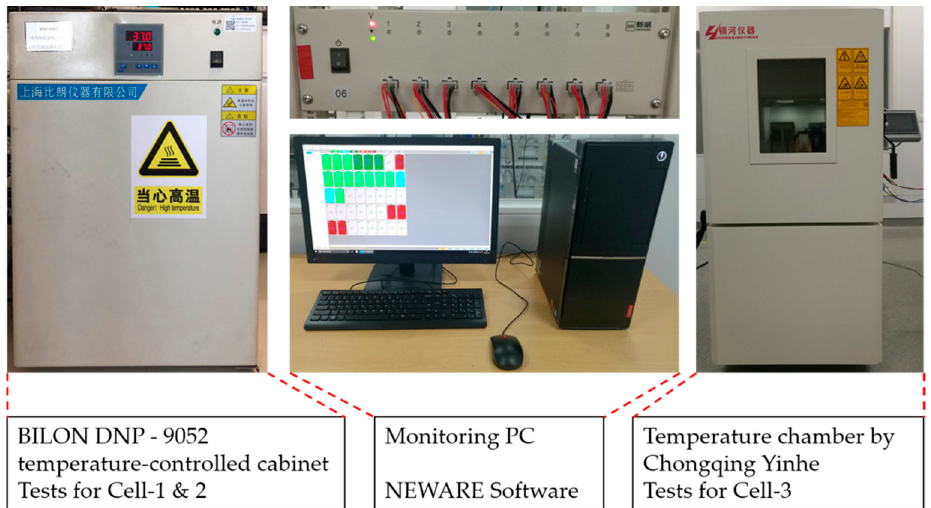
Figure 3. Schematic diagram of the experimental platform.